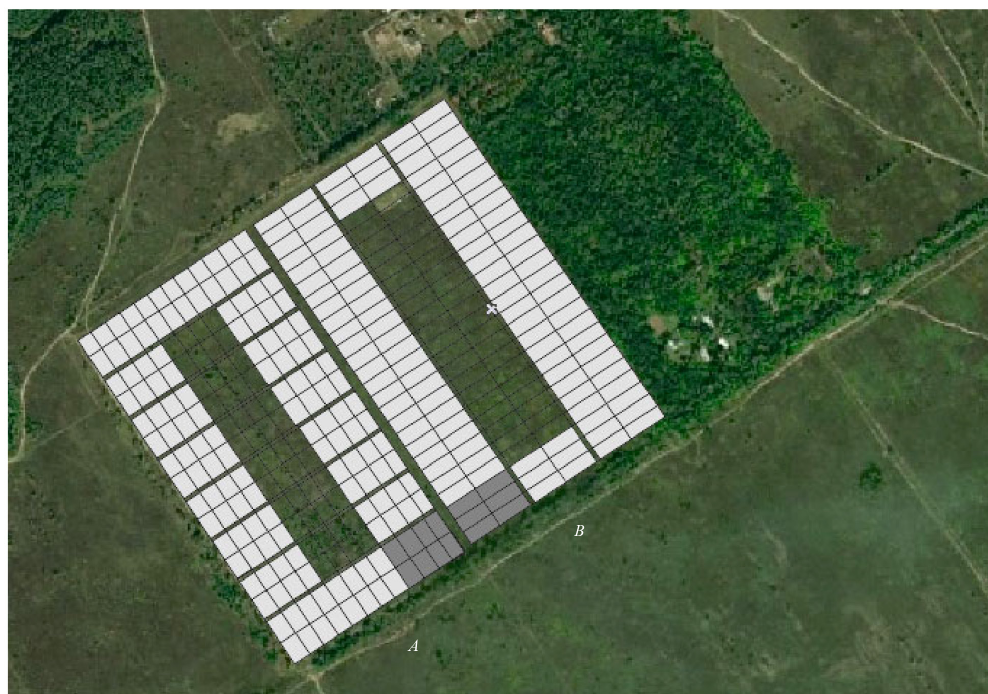
Figure 9. Optional consolidated land plots placement within a land